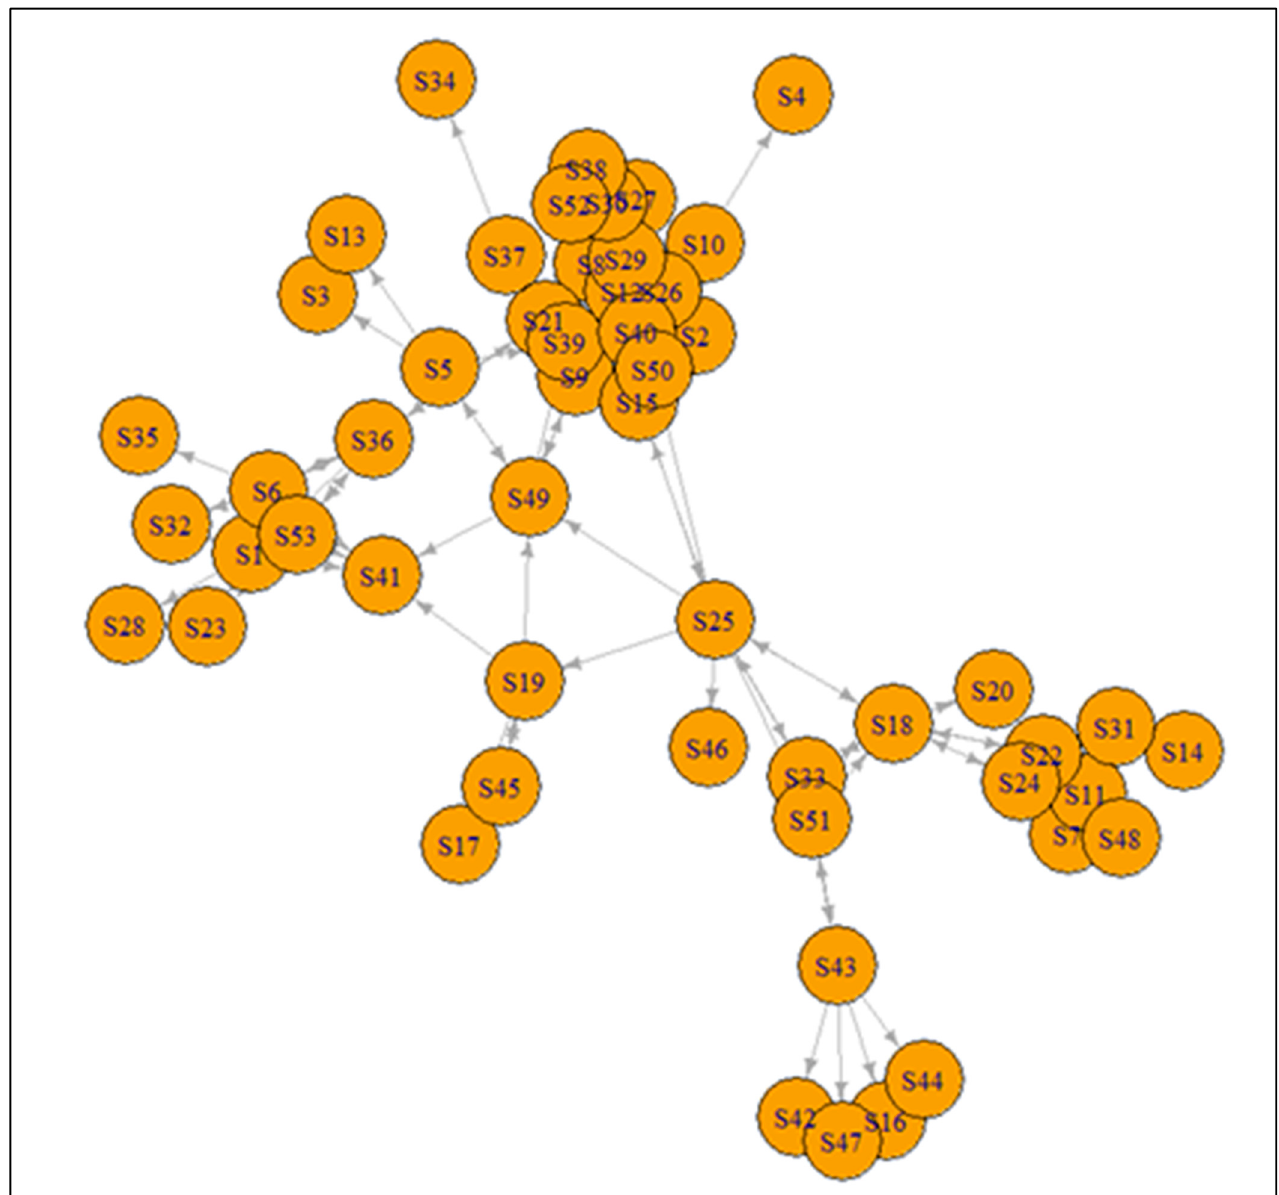
Figure 3. The visualization of graph G (V,E).